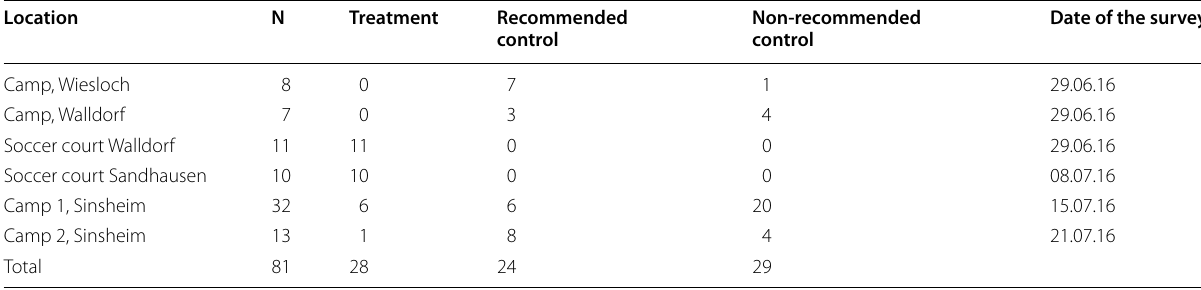
Source ZEW inclusive soccer project survey